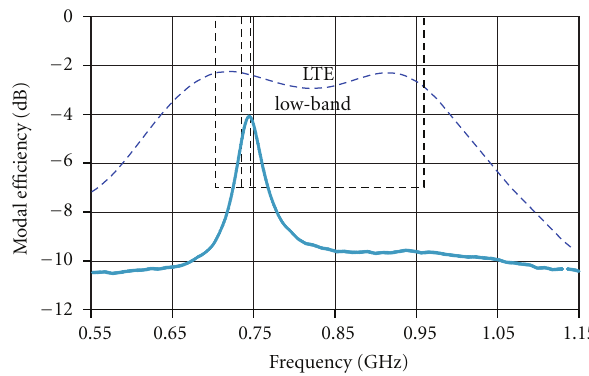
Figure 1: Frequency dependence of modal e ffi ciencies for a simulated 2-port MIMO antenna